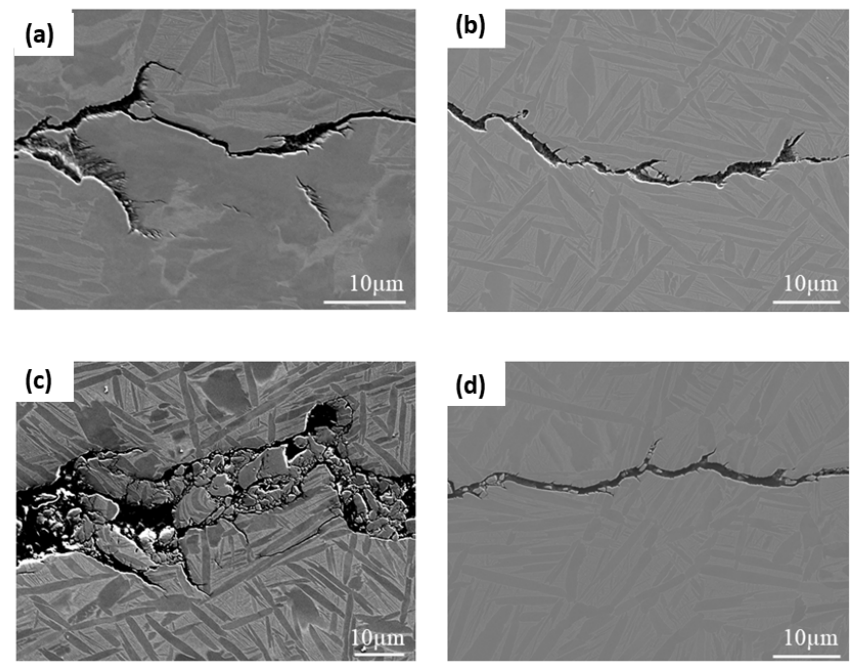
Figure 15. Micrographs ( a ) IP 200 − 500 °C ( b ) OP 200 − 500 °C ( c ) IP 200 − 550 °C ( d ) OP 200 − 550 °C. ( a , c ) show more evidence of creep damage ahead of the crack tip.